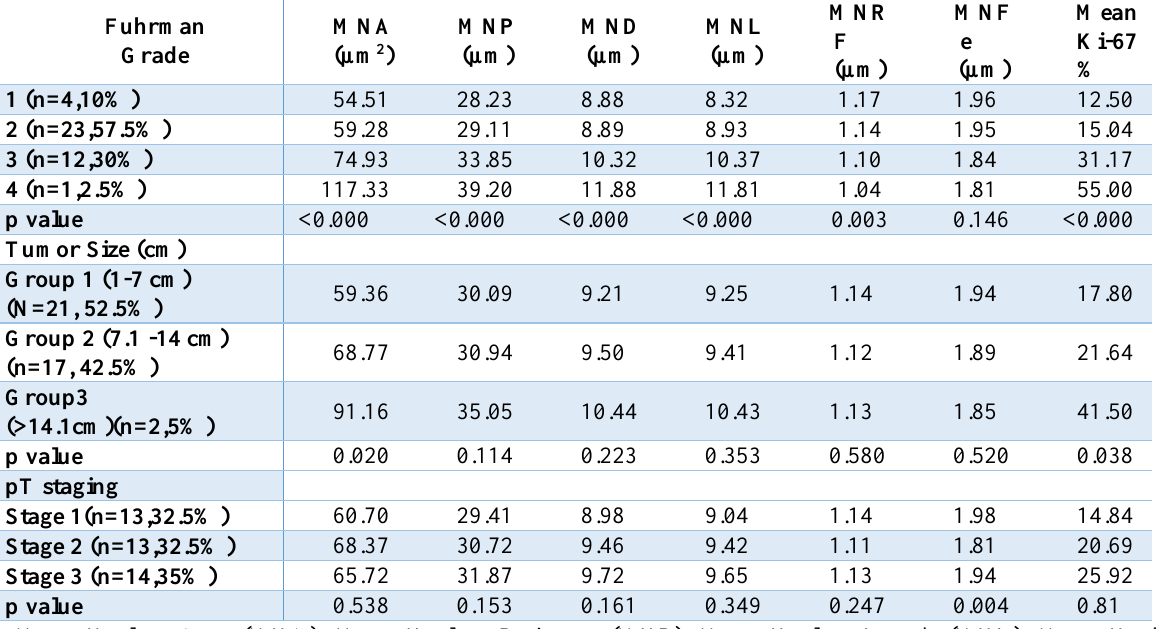
Table 2. Correlation Between Tumor Size, Fuhrman Grade, Pathological Tumor Stage, Ki-67 and Nuclear Morphometry